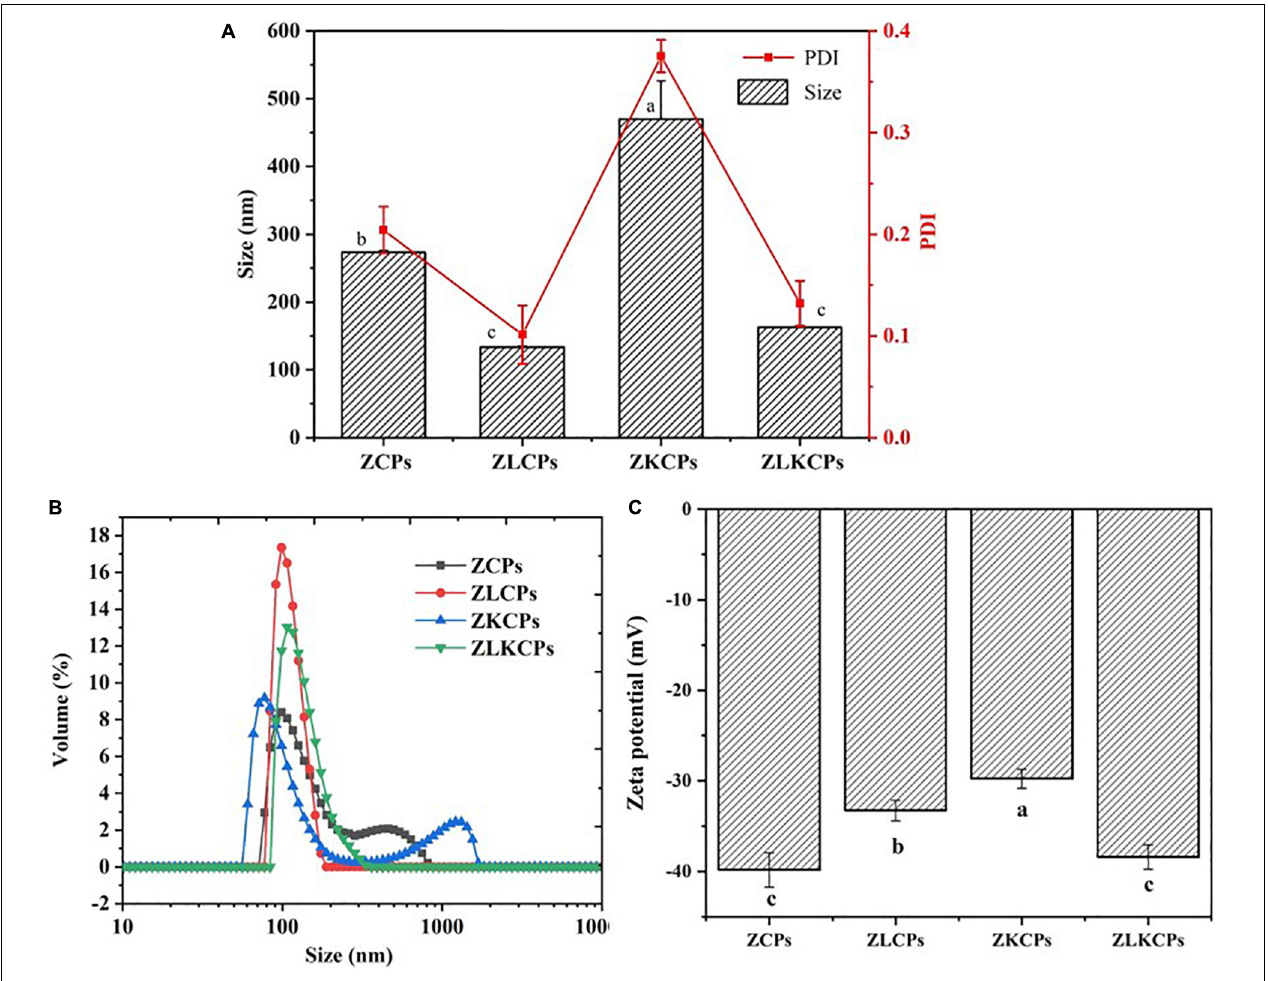
FIGURE 2 | Average diameter and polydispersity index (PDI) (A) , the distribution of particle size (B) , and the zeta potential (C) of different colloidal